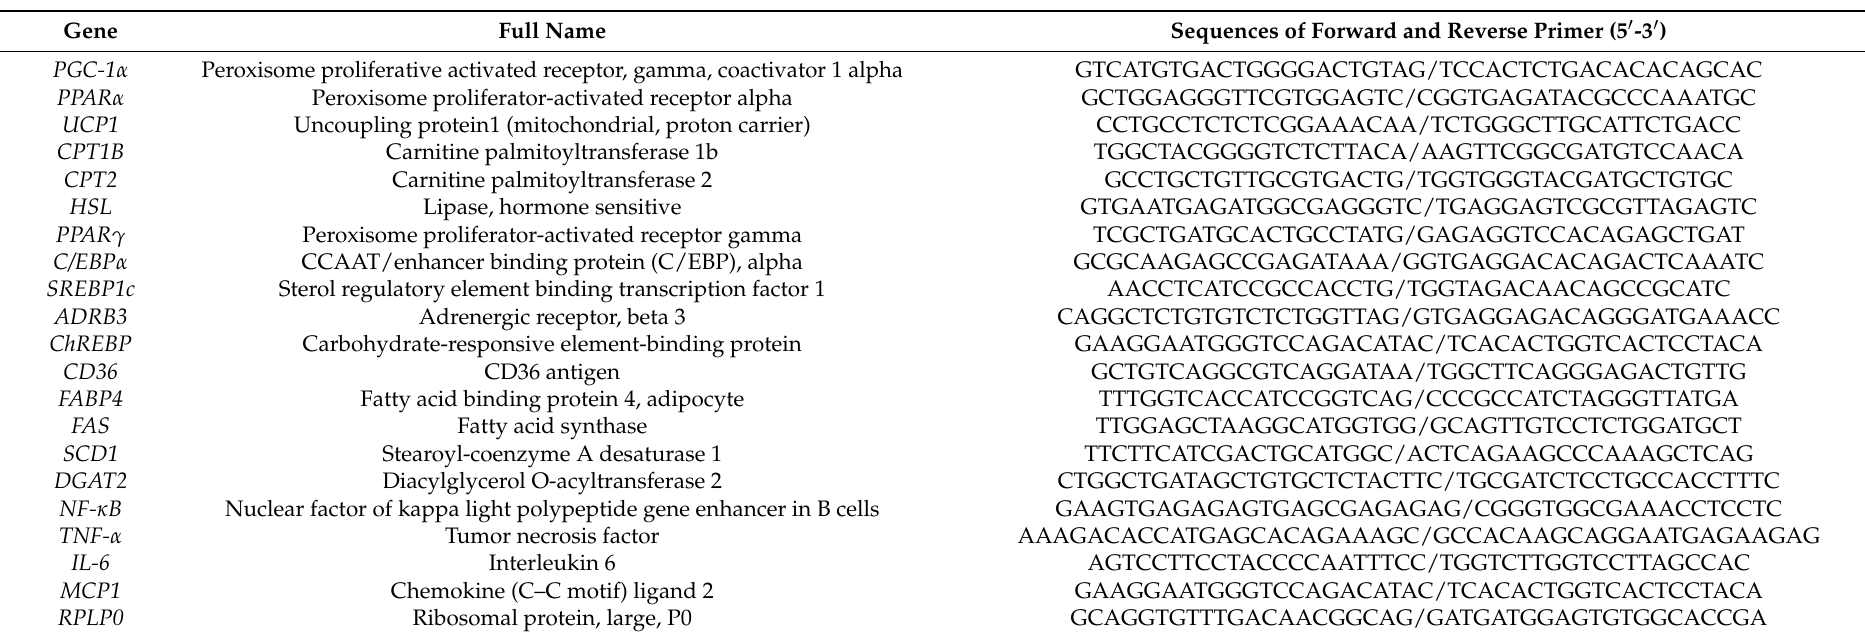
Table 3. Primer sequences for